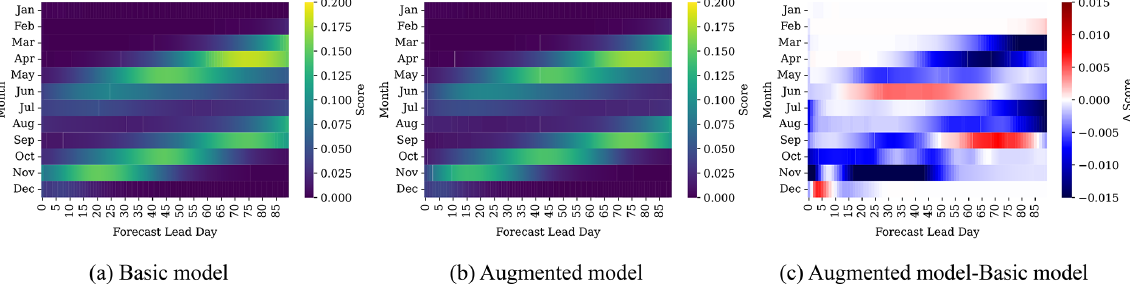
Figure 5. Brier score of the (a) Basic and (b) Augmented model as a function of lead time. Their score difference is shown in (c) . Most differences are observed in the breakup and freeze-up